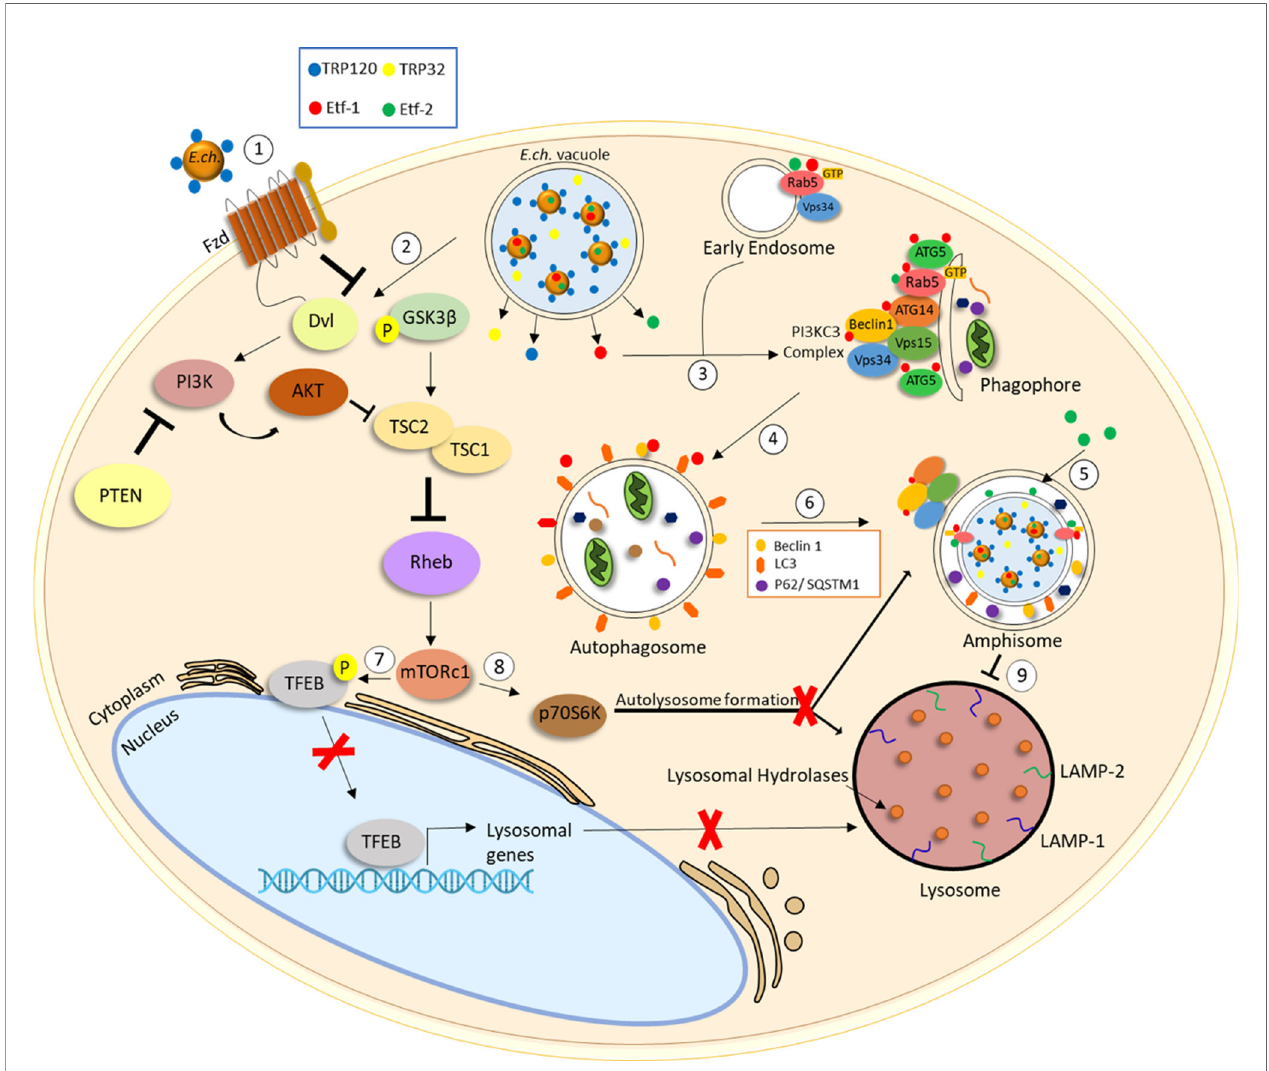
FIGURE 2 | E. chaffeensis interplay with the autophagic pathway. (1) E. chaffeensis dense-cored cells express effectors important for Wnt signaling including T1SS effectors TRP120 and TRP32. E. chaffeensis stimulates phagocytosis for entry through interaction between TRP120 and the Fzd receptor/co-receptor complex. (2) E. chaffeensis- mediated Wnt-PI3K/Akt signaling stimulates increased levels of phospho-GSK3- b reducing TSC2 and increasing Rheb activity leading to mTOR activation. (3) E. chaffeensis T4SS effector Etf-1 is secreted into the host cell cytoplasm and interacts with Beclin1, PI3CK complex and Rab5-GTP to stimulate phagophore formation. (4) ATG5 and LC3 engage to induce autophagosome formation in a class III PtdIns3K-dependent manner. (5) E. chaffeensis T4SS effector Etf-2 localizes to E. chaffeensis vacuole membrane and binds to RAB5-GTP to delay endosome maturation. (6) Autophagosomes displaying Beclin1, LC3II and p62/ SQSTM1 fuse with E. chaffeensis inclusions to form amphisomes. (7) mTOR activation leads to TFEB phosphorylation and inhibition of TFEB nuclear translocation. Inhibition of TFEB nuclear translocation prevents transcription of genes involved in lysosomal biogenesis and (8) increased phospho-p70 S6 kinase activity inhibits autolysosome